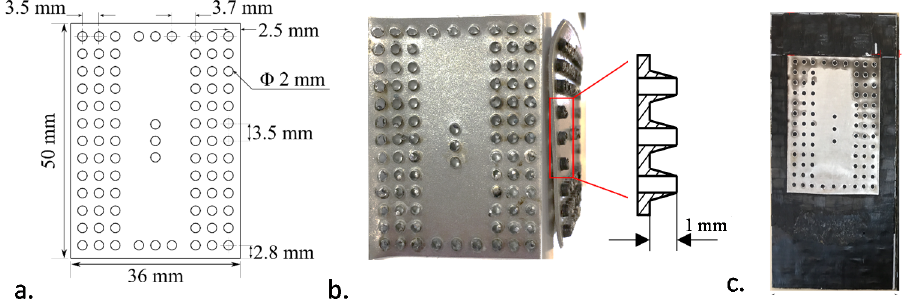
Figure 5. ( a ) Perforated metallic insert (first design); ( b ) Metallic insert with flanged holes (second design); ( c ) FRPC single specimen with metallic insert after over-molding with thermo-compression